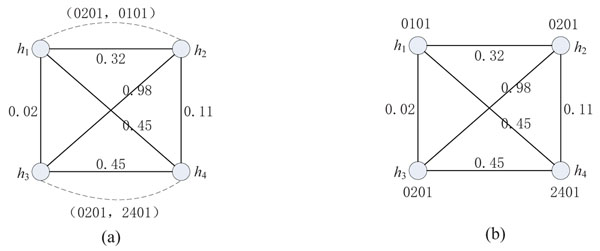
An example of a weighted similarity graph and one of its feasible form (a): An example of a weighted similarity graph. A solid line denotes a similarity edge and a dashed arc denotes a constraint edge. (b): A feasible form of (a)